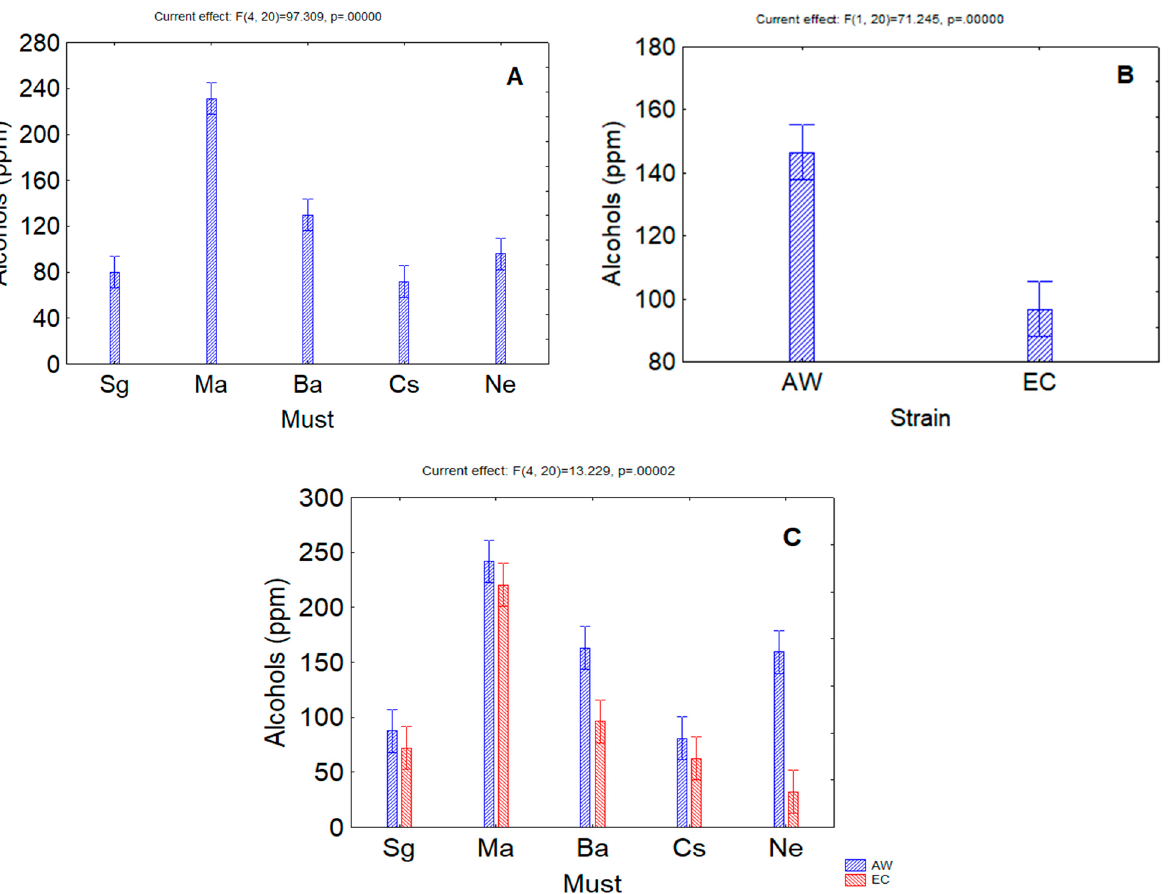
Figure 3. Decomposition of the statistical hypothesis for the effects of must ( A ), strain ( B ), and interaction must × strain ( C ) on the total amounts of alcohols. Bars denote 95%-confidence intervals. Sg, Sangiovese; Ma, Magliocco; Ba, Barbera; Cs, Cabernet-Sauvignon; Ne, Negroamaro. EC, strain EC1118; AW, strain AWRI796.